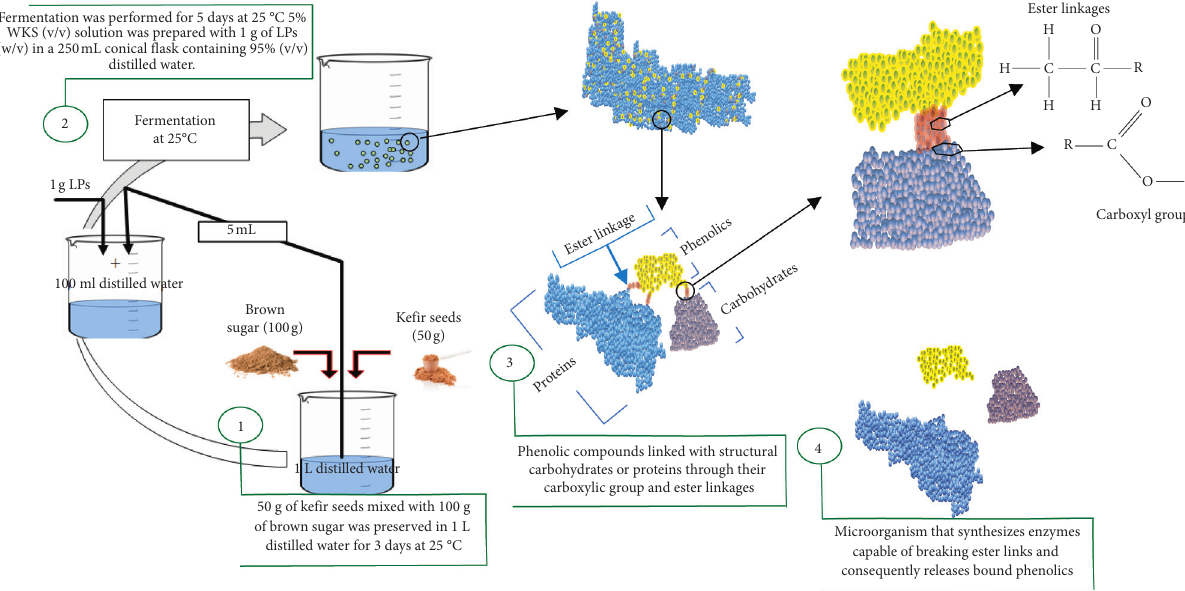
Figure 1: Schematic diagram of the fermentation process steps. (1) Preparation of water kefir seeds (WKS). (2) Preparation of protein solution (1%, w/v) and 5% (v/v) WKS in distilled water at 25 ° C for 5 days of fermentation. (3) Protein complexes with phenolic compounds and carbohydrates connected via ester linkages. (4) Breakdown of the ester linkages by microorganisms and their enzymes, resulting in the release of protein complexes, phenolic compounds, and